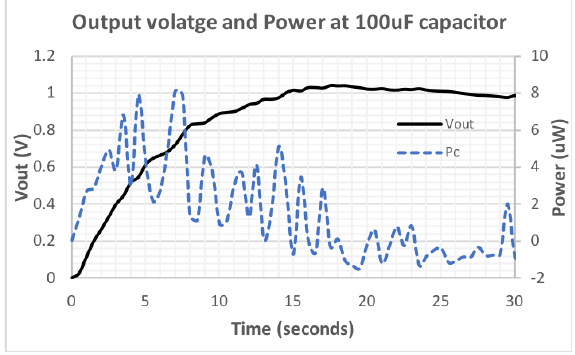
Figure 22. Output voltage of the RFEH scheme 2 at a load 100 µ F capacitor.